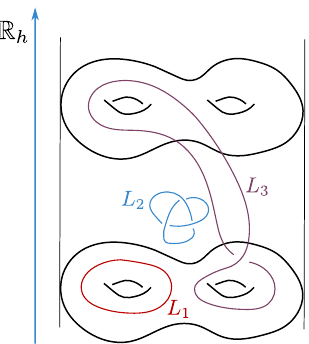
Figure 1 . Illustration of the three-manifold M = C × R h . A generic link L ⊂ M , such as the knot L 3 in the figure, has a finite extent along the R h direction that can’t be isotoped away. For special links that can be isotoped to simple closed curves on C , such as the knot L computes the generating function of protected spin characters for the corresponding 1 / 2 -BPS line defects. There are also special links which are contained in a 3-ball, such as the trefoil knot L figure. In this case F ( L ) is expected to compute the 1-parameter limit of HOMFLY polynomial (1.6).